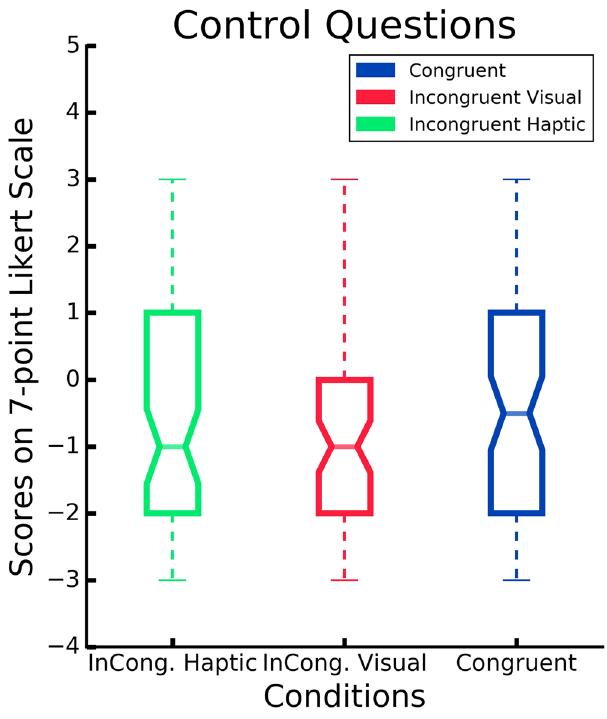
Figure 2. Self-reported experience of ownership. Y-axis: Responses on the 7-point Likert scale ranging from − 3 (strongly disagree) to 3 (strongly agree). Scores above 0 indicate a feeling of ownership. Control Questions: mean of the three questions related to the ownership illusion per